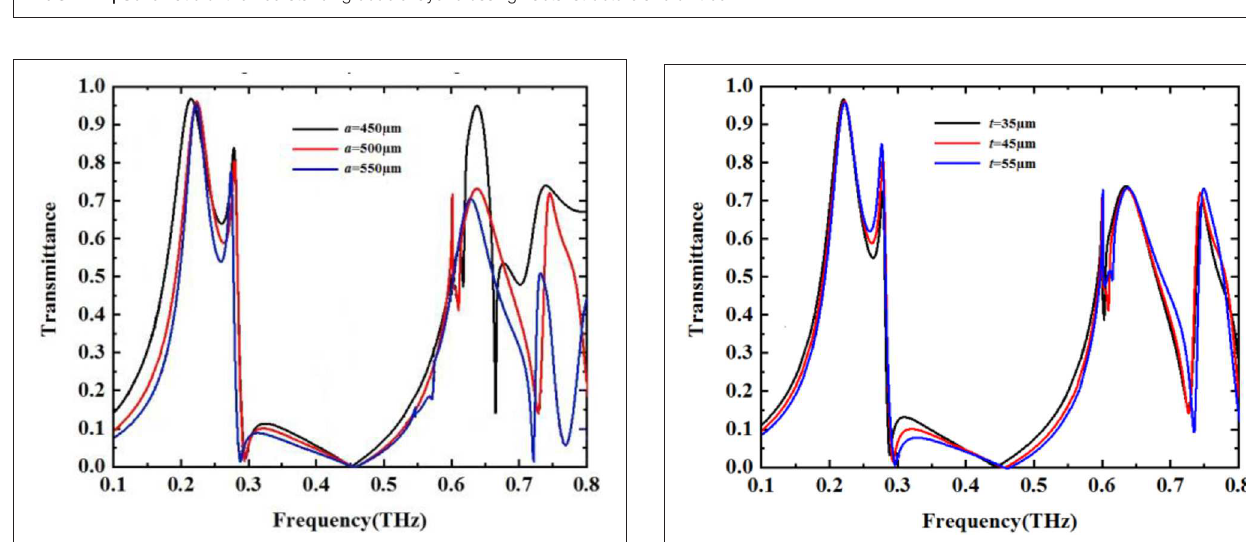
FIGURE 1 | Schematic of the free-standing double-layer crossing fractal structure and unit cell.